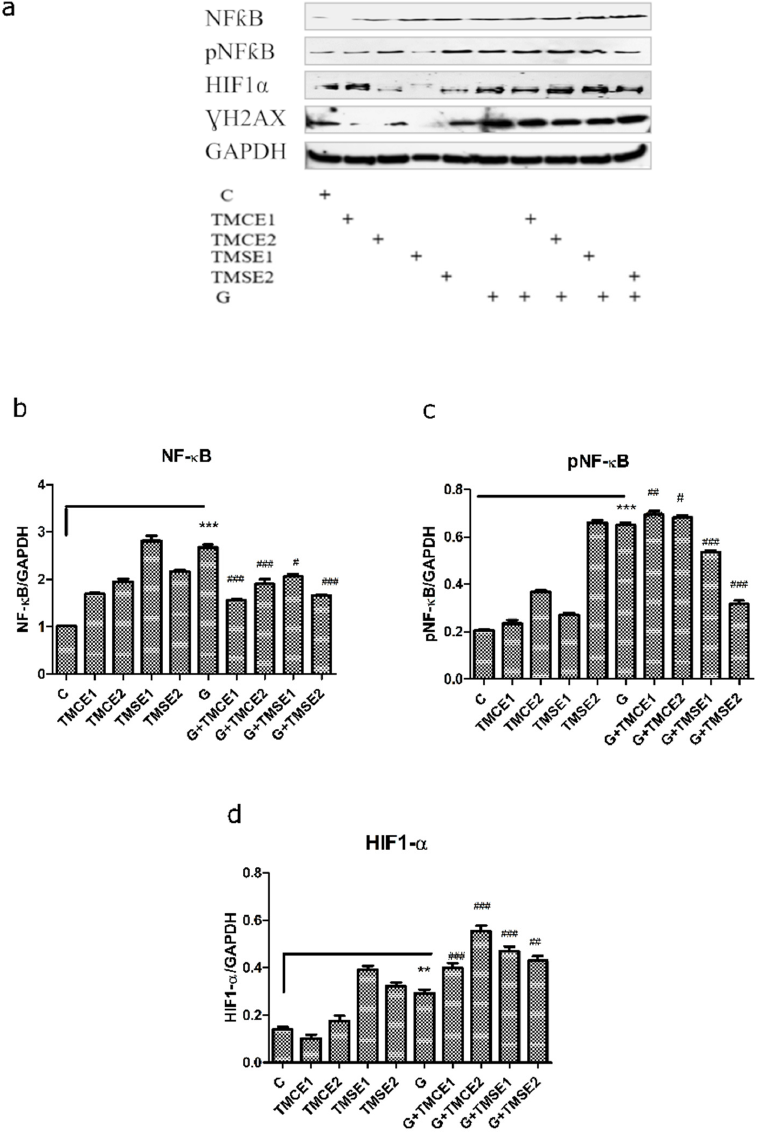
Figure 4. NF-kB, phosphorylated (p)NF-kB and HIF1- α expressions in HUVECs after exposure to hyperglycemia and normoglycemia and treatment with two doses of Thymus marschallianus extracts. Image analysis of WB bands was done by densitometry in upper panels ( a ) and results were nor- malized to GAPDH in lower panels ( b – d ). Exposure to hyperglycemia (G) increased the total NF- kB expression and its activation and enhanced the HIF1- α valued compared to the control cells. The treatment with the two extracts diminished the total NF-kB expression and reduced the active form of NF-kB, especially TMSE. Both extracts improved HIF1- α expression in hyperglycemic medium while TMCE increased the activation of NF-kB. The statistical significance between the treated cells and control group was assessed with two-way ANOVA followed by the Bonferroni post-hoc test. Each bar represents mean ± standard deviation (n = 3); ** p < 0.01 and *** p < 0.001 vs. control (un- treated cells); # p < 0.05, ## p < 0.01, and ### p < 0.001 vs. cells exposed to hyperglycemia.